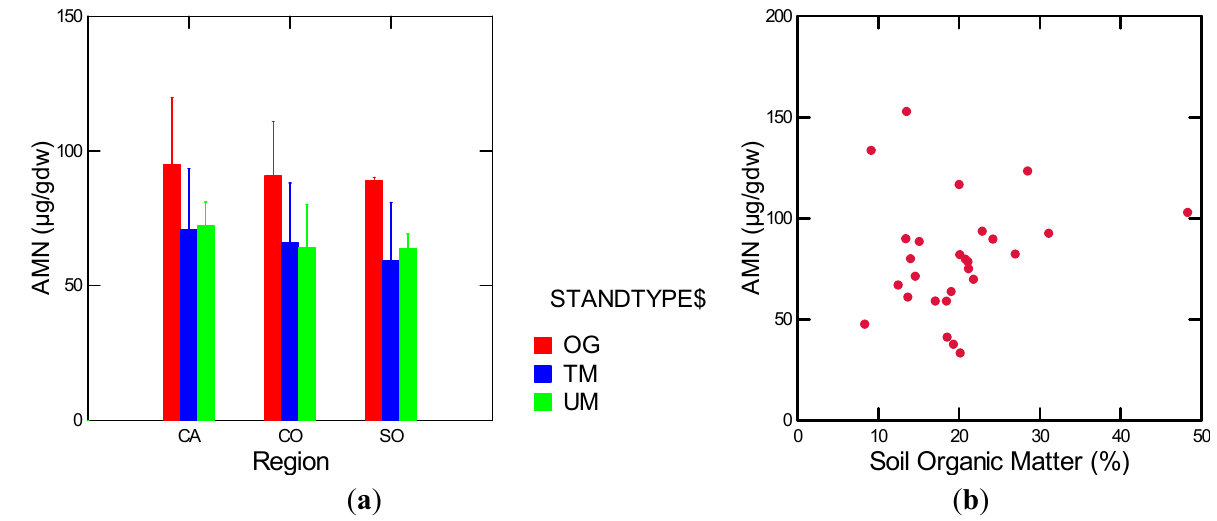
Figure 5. ( a ) Anaerobic mineralizable nitrogen (AMN) by regions and stand types within regions. One outlying triad in the Siskiyous is excluded. CA = Cascades, CO = Coast Range, SO = Siskiyous. Bars = standard errors; ( b ) The relationship between anaerobic mineralizable nitrogen (AMN) and percent soil organic matter (all sites